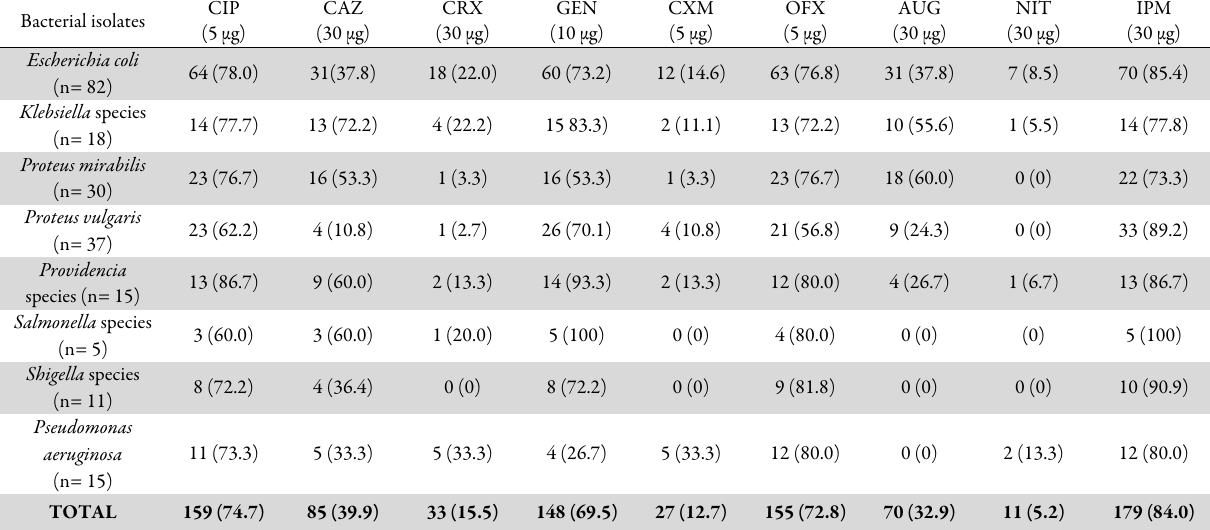
Table 4. Susceptibility profile of non-ESBL producing bacterial isolates recovered from cattle feces Bacterial isolates